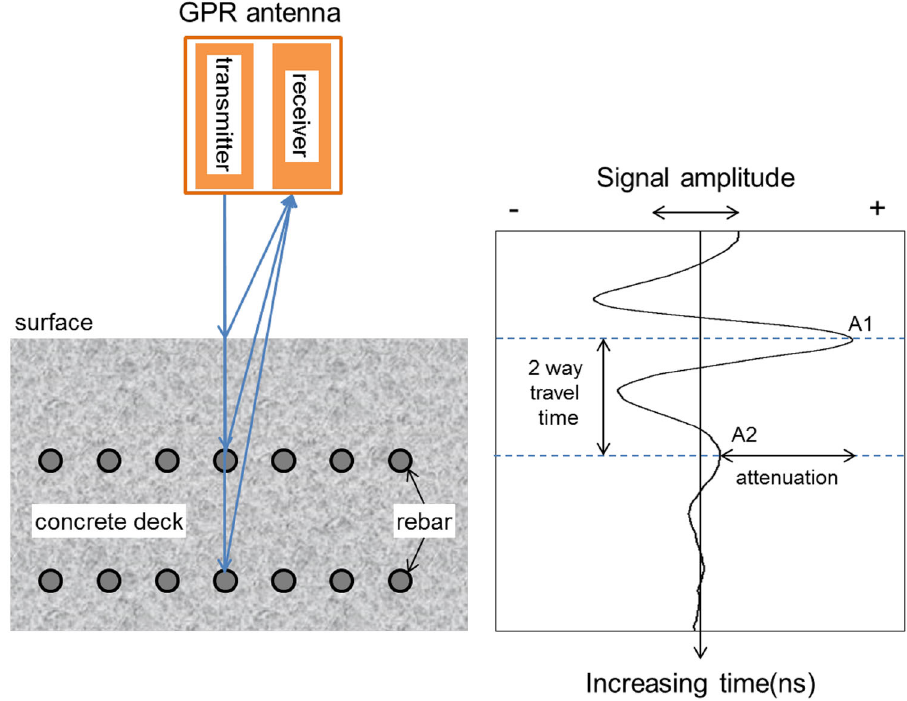
Fig. 2 GPR scanning on a bare concrete deck: a possible path of EM waves in concrete bridge decks and b typical signal measured from a receiver antenna.